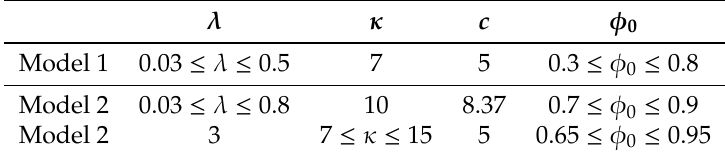
Table 2. The input parameters λ , κ , c and φ 0 for the simulations.